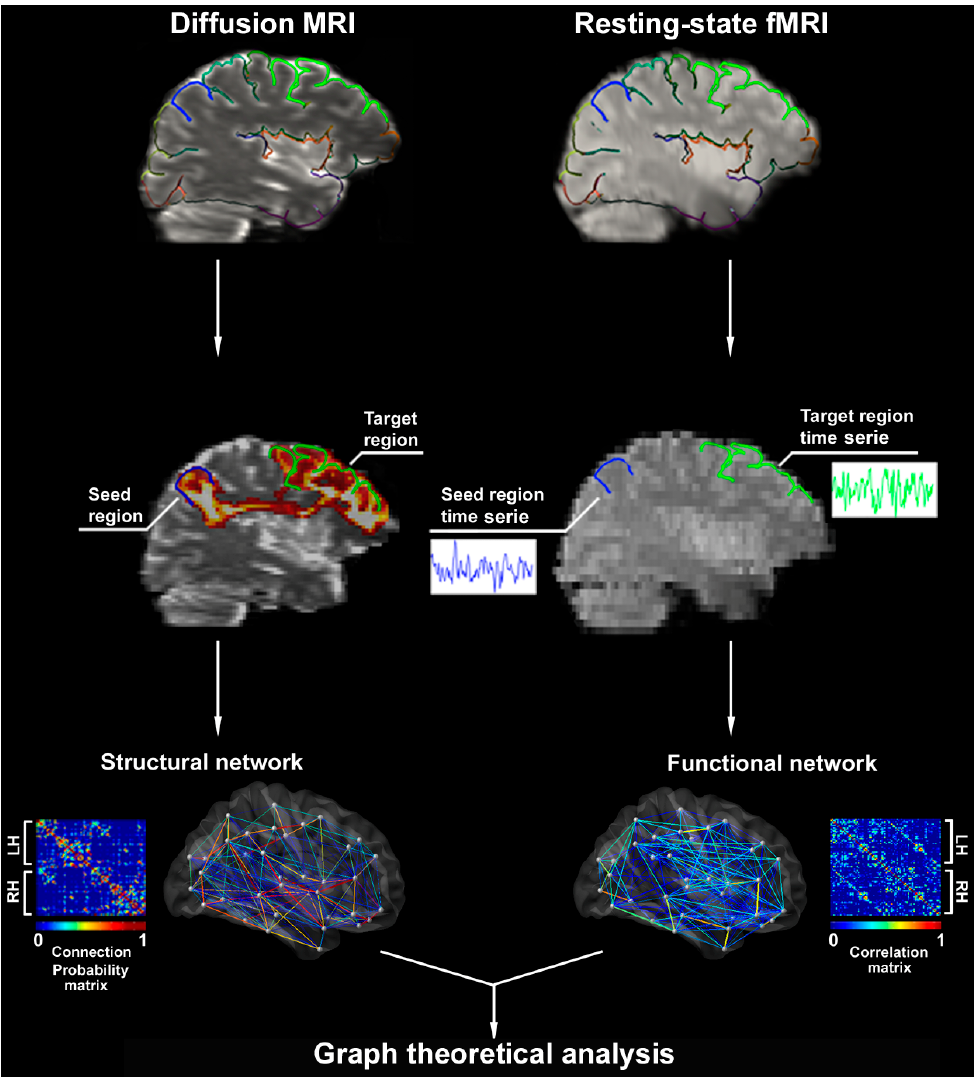
Figure 1. Construction of structural and functional networks. Upper panels show parcellated surfaces (color-coded by lobes) mapped onto the diffusion and resting-state fMRI. In the middle panels, each parcel represents a seed and its connectivity is estimated to all other parcels. Diffusion tensor-probabilistic tractography and functional MRI time series correlations between the superior frontal ( green ) and the post-central ( blue ) parcels are shown. Lower panels display connection probabilities (represented by partial correlation coefficients between all pairs of parcels) used to generate structural and functional association matrices. Matrices are the substrate for graph-theoretic analyses of network properties. In the graph, nodes represent parcels (white dots) and edges (lines linking nodes) pairwise connections color-coded according to connectivity strength. Abbrev : LH/RH: left/right hemisphere.